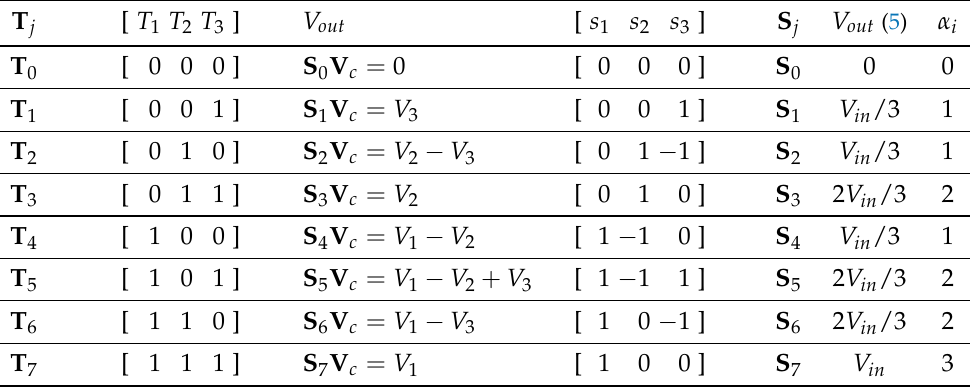
Table 2. Relations between the IGBTs signal vectors T j , the output voltage V out and the configuration vectors S j when n =